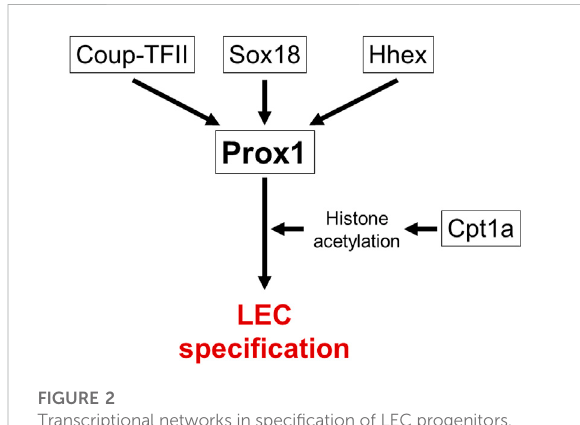
FIGURE 2 Transcriptional networks in speci fi cation of LEC progenitors. Prox1 is a master transcriptional regulator gene of LEC speci fi cation. Several transcription factors (Sox18, Coup-TFII, Hhex) and Cpt1a-modulated histone acetylation regulate Prox1 expression. Causative genes for fetal nuchal edema in mice are surrounded by